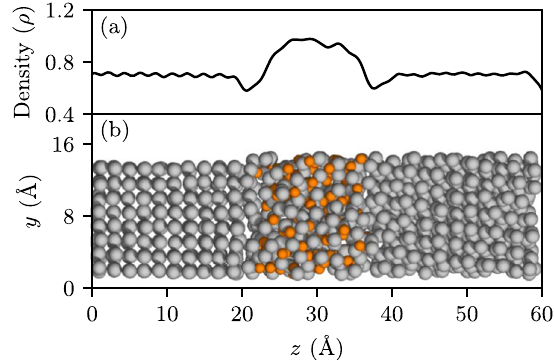
Fig. 2 Density analysis of a junction model. a The material density in the junction model as a function of position. b The fi nal atomic structure of a Al – AlO x – Al junction model where oxygen and aluminium atoms are depicted as orange and grey spheres, respectively. This calculation was performed with the S – M